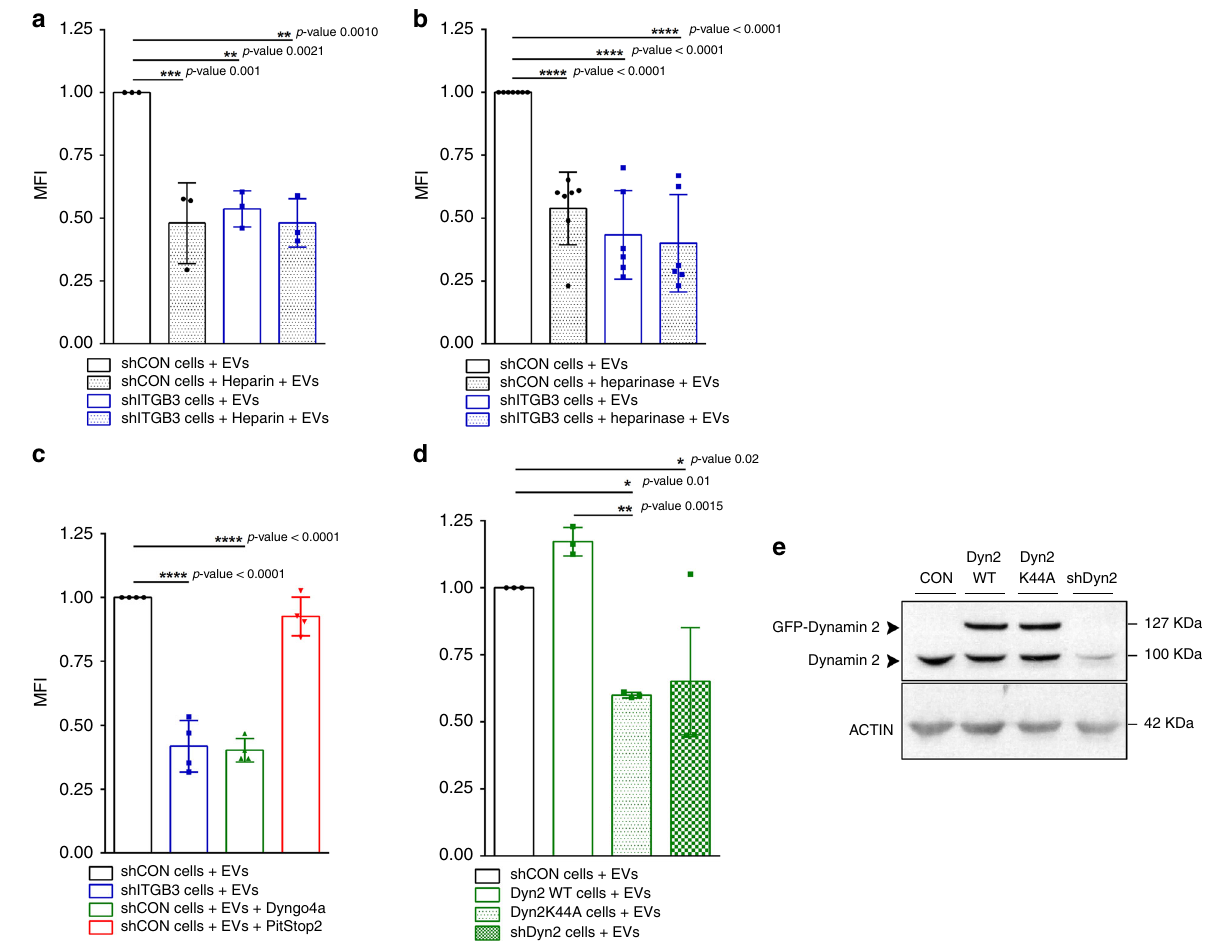
Fig. 2 Endocytic uptake of EVs depends on ITGB3, HSPGs and DYNAMIN activity. Internalization of 2 – 5 µ g mL − 1 PKH26-labelled EVs derived from MDA.MB.231 cells by MDA.MB.231 shCON or MDA.MB.231 shITGB3 cells, measured by FACS. a Uptake of vesicles was measured after pretreatment with 10 μ g mL − 1 heparin as a competitive inhibitor for cell – surface heparan-sulfated proteins for 30 min. b Uptake was measured in cells that were untreated or pretreated with 1.2 mIU mL − 1 heparinase I and 0.6 mIU mL − 1 heparinase III for 3 h before EV incubation. c Uptake of vesicles was measured after pretreatment with 20 μ M Dyngo4a or 10 μ M Pitstop 2 for 30 min in shCON cells. d Uptake of vesicles measured in MDA.MB.231 cells infected with Dyn2WT − Dyn2K44A − and shDyn2 constructs. e Representative immunoblot showing endogenous and exogenous levels of DYNAMIN 2 protein. Source data are provided as a Source Data fi le. (* p value < 0.05, ** p value < 0.01, *** p value < 0.001, **** p value < 0.0001, n = 3 for panel 2a, d; n = 4 for panel 2c; n = 7 for panel 2b). Data are represented as mean ± SD in ( a – d ). Statistical analysis including two-tailed unpaired Student ’ s t test data was carried out using GraphPad Prism